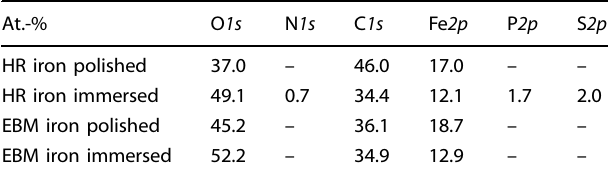
Table 2. Surface composition in at.-% of polished and immersed HR iron and EBM iron samples as measured by XPS.